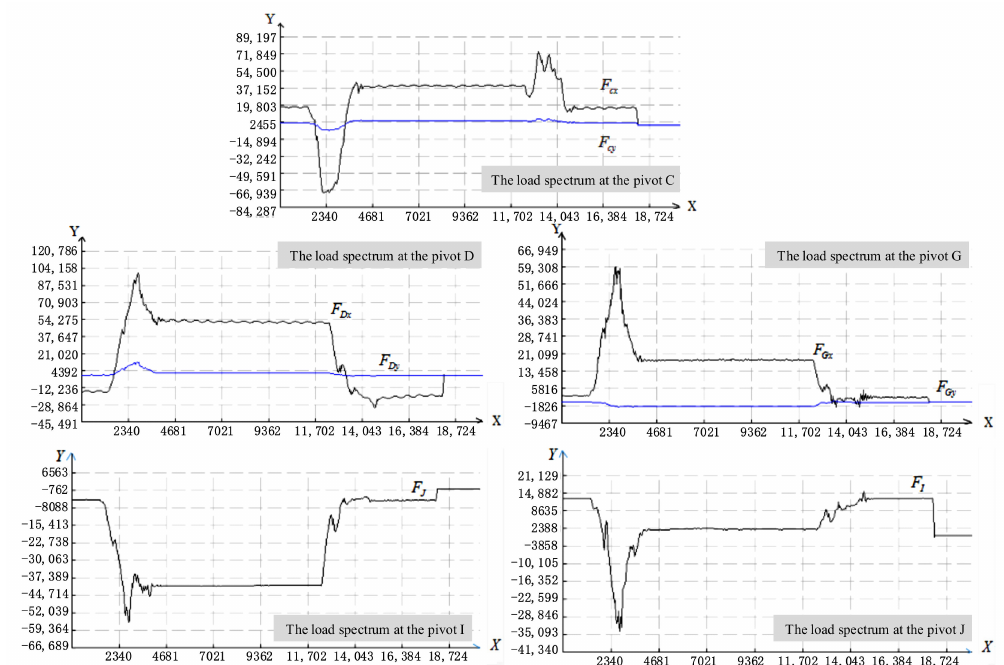
Figure 12. The load spectrum at the pivots.